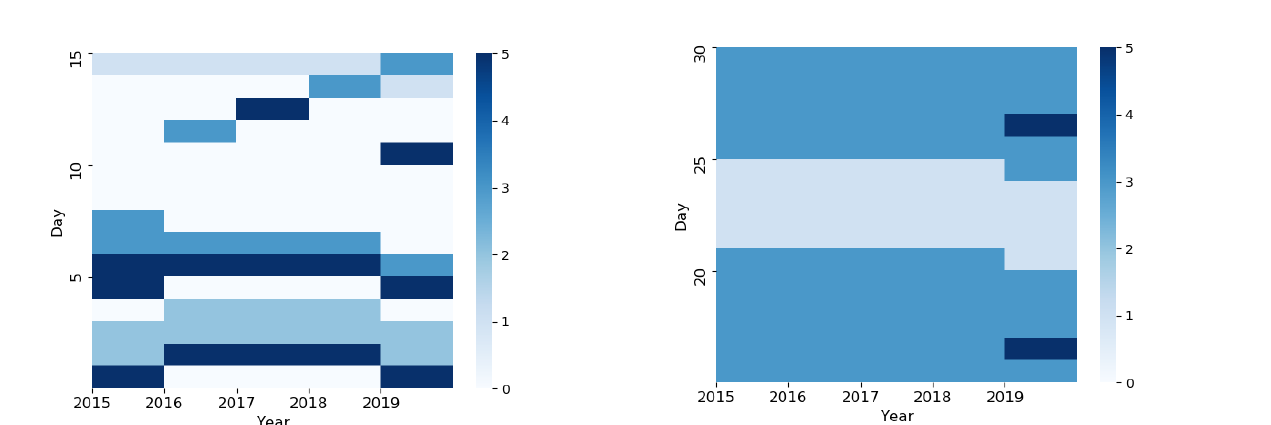
Figure 18: Clustering output for O 3 for first 15 days in Q 3 over 2015 to 2019.